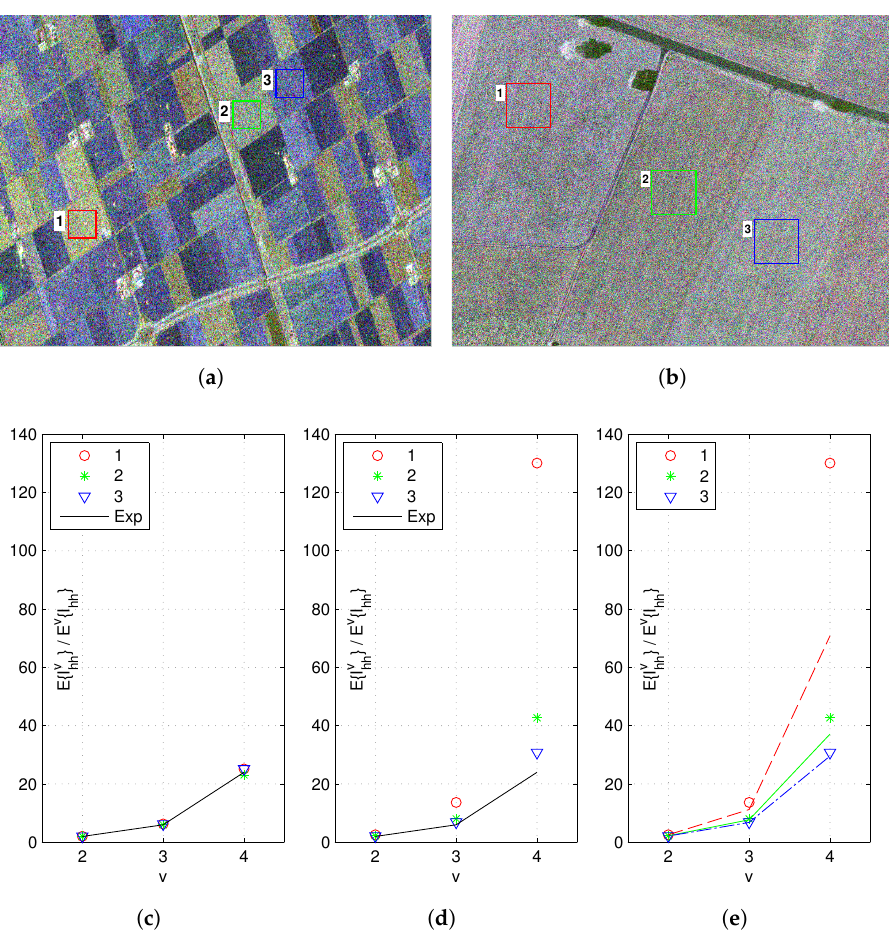
Figure 3. NIMs of the 2nd, the 3rd and the 4th order estimated from three crops areas in a RADARSAT-2 data and a F-SAR data. ( a ) Pauli decomposition and ROIs of the RADARSAT-2 image. ( b ) Pauli decomposition and ROIs of the F-SAR image. ( c ) NIMs of the ROIs in the RADARSAT-2 data and the exponential distribution. ( d ) NIMs of the ROIs in the F-SAR data and the exponential distribution. ( e ) NIMs of the ROIs in the F-SAR data and Weibull